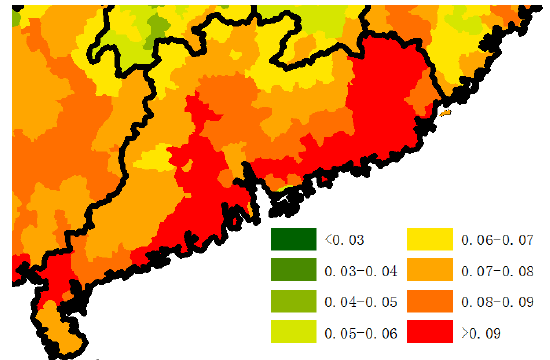
Figure 17. The 85+/65+ ratio of county scale in Guangdong province.